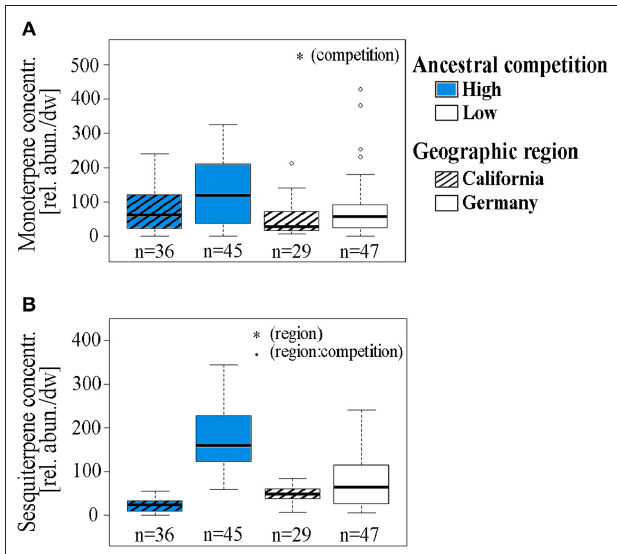
FIGURE 3 | (A) Foliar monoterpene and (B) sesquiterpene concentrations of Erodium cicutarium plants (2nd laboratory generation) displayed as sum of relative compound abundances, normalized by sample dry weight and peak area of the internal standard. Data are shown for two geographic regions of seed origin: California, USA (hatched boxes) and Bavaria, Germany and two levels of ancestral competition: high (blue boxes), and low. The box and whisker plots show the median (horizontal line), quartiles (boxes), 5 and 95% percentiles (whiskers), and outliers of each data set (open circles). Levels of significance: * p < 0.05, • p < 0.1, p > 0.01, not significant. The results of statistical analyses are displayed in Table 2